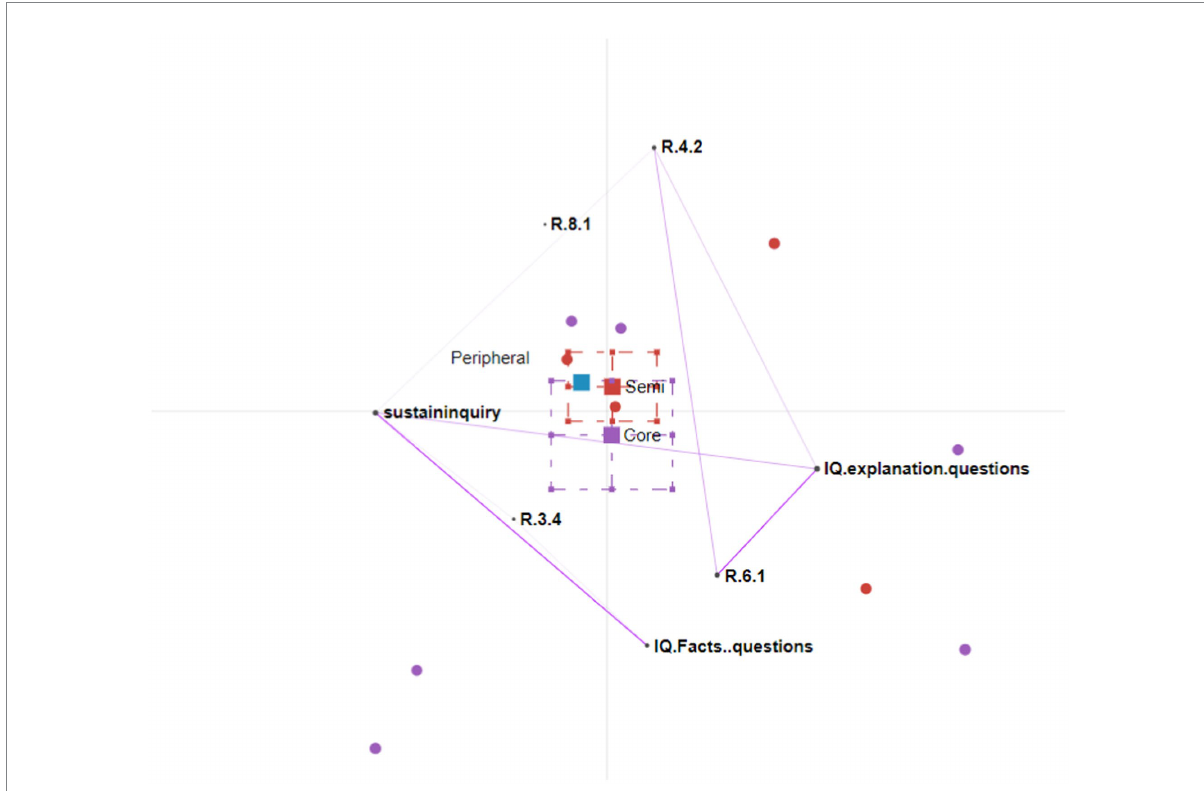
FIGURE 3 Epistemic network analysis participation graph for leader group. Core = leader; semi =